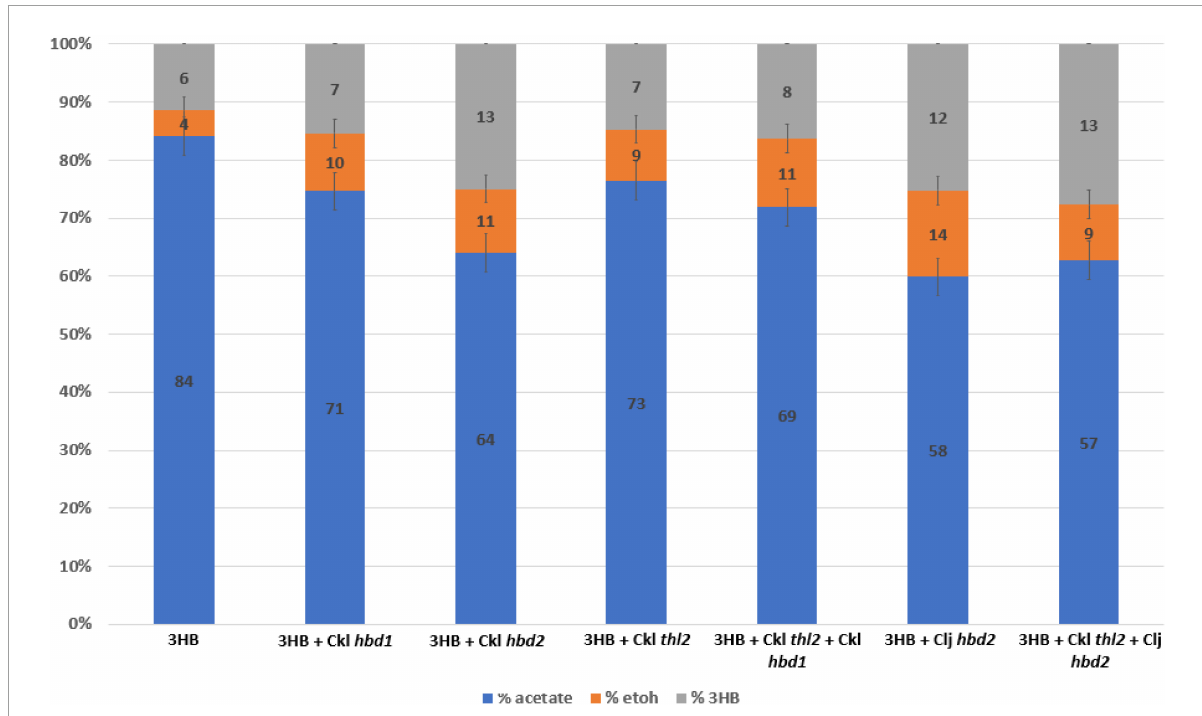
FIGURE4 Heterotrophic fermentation product profile of Clostridium ljungdahlii strains expressing hbd1 vs. hbd2 in the 3HB strain background. Carbon distribution of fermentation products is indicated by the bar chart%, while the number label is the mM amount after 5 days of growth. The “integrated 3HB strain” contains the atoB from Escherichia coli and CoA transferase from C. acetobutylicum integrated into the genome. Replicating plasmids expressing a combination of thiolase, hbd1 , and hbd2 were transformed into the integrated 3HB strain and measured for 3HB production. The expression of hbd2 results in superior 3HB production. Ckl for C. kluyveri , Clj for C. ljungdahlii . Carbon distribution to 3HB out of the total products is given as a percentage above bars. Error bars show standard error of the mean (SEM) for 3 biological